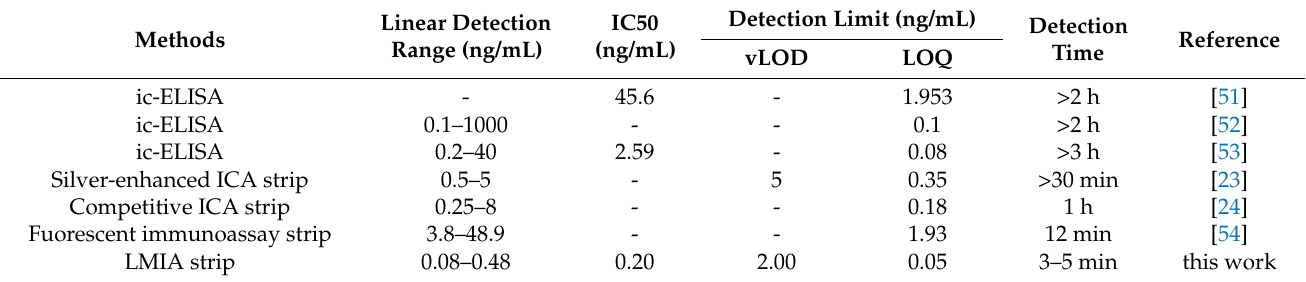
Figure 8. Characterization of immunochromatographic test strips based on the mAb for cadmium ion, concentration unit, ng/mL. ( A ) Sensitivity of test strips; ( B ) Standard curve of test strip sensitivity; ( C ) Specificity of test strips; ( D ) Influence of sample matrix effect on test strip (‘×’ represent dilution multiple); ( E ) Measurement of actual samples. Table 3. Comparison with the reported Cd 2+